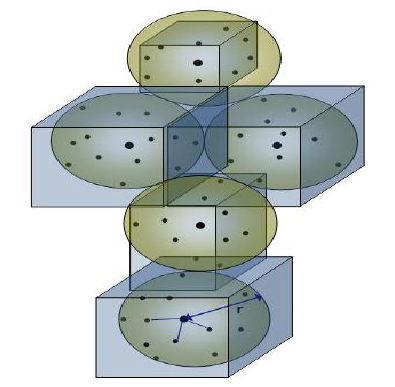
Figure 1. A number of points is grouped together to form cubical voxels of maximum size 2 r . The actual voxel sizes vary according to the maximum and minimum values of the neighboring points found along each axis to ensure the profile of the